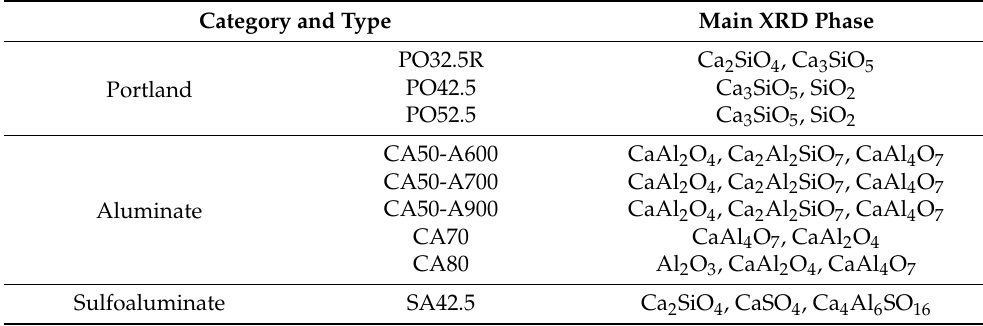
Table 2. Cements and compositions.